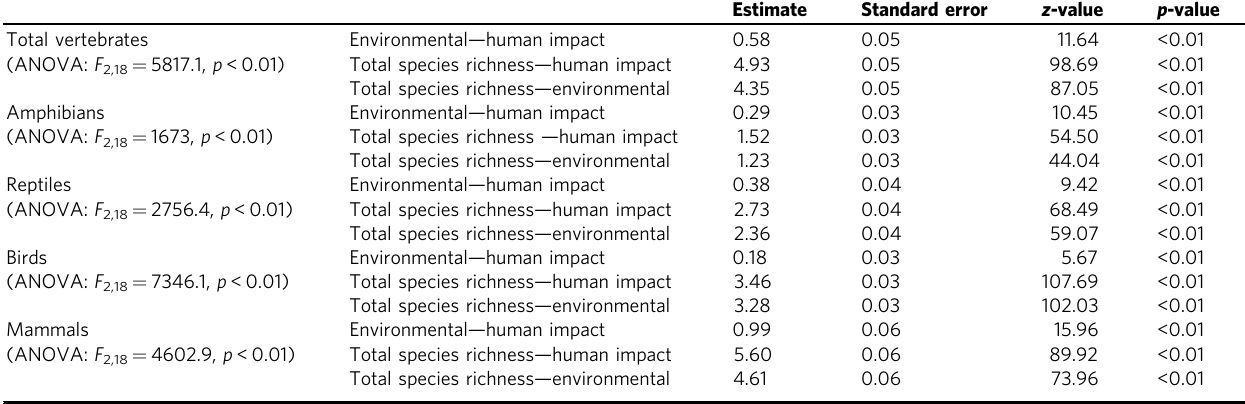
Table 2 Comparing the importance of environmental and human impact